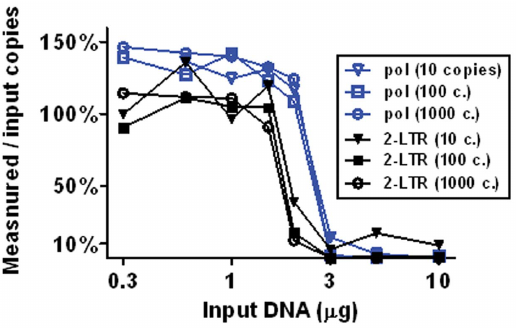
Figure 1. PCR Inhibition by background host DNA. Plasmids containing pol (pNL4-3) or the 2-LTR junction sequence were spiked into varying amounts of cellular background (salmon sperm) DNA prior to droplet formation. The figure shows the measured copy number as a percentage of the value expected from A 260 /A 280 absorptivity of the plasmid. Loading of over 1.5 m g of DNA per well greatly reduced the measured copy number for all samples tested. Above 3 m g/well, droplet formation was also inhibited (not